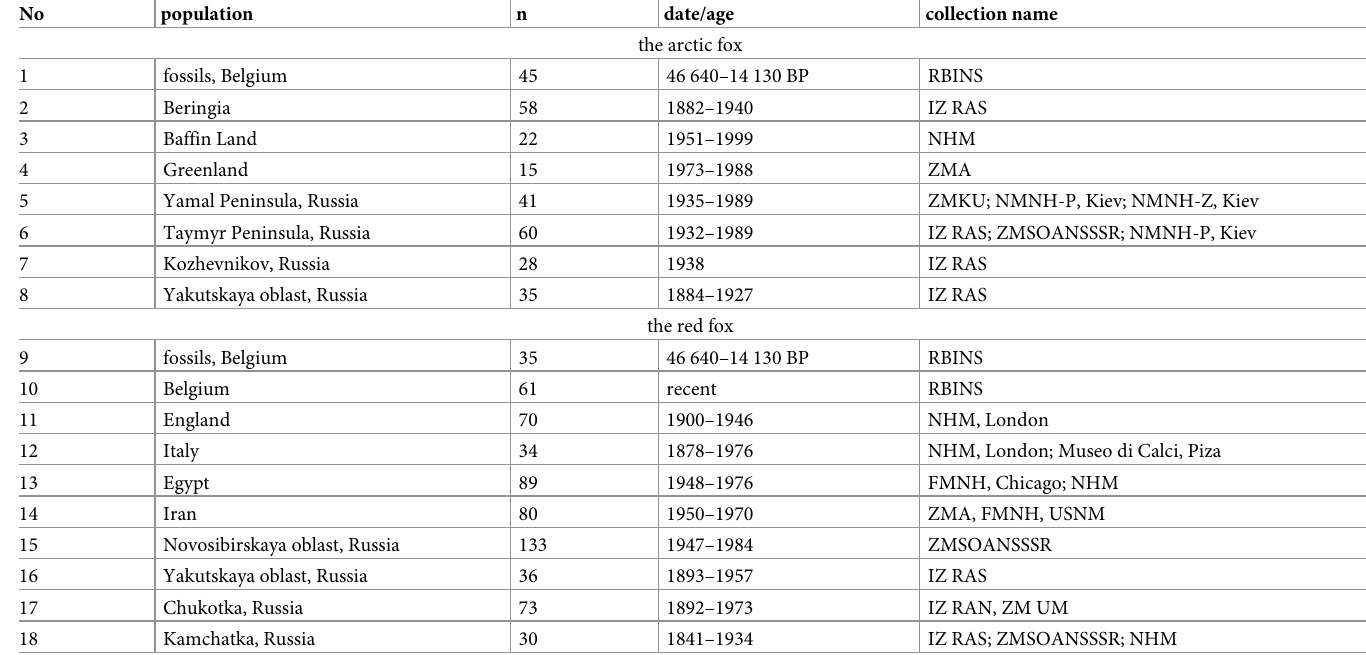
Table 1. List of samples of the red and arctic foxes used in the study with specimen numbers, collection times, and sources of the